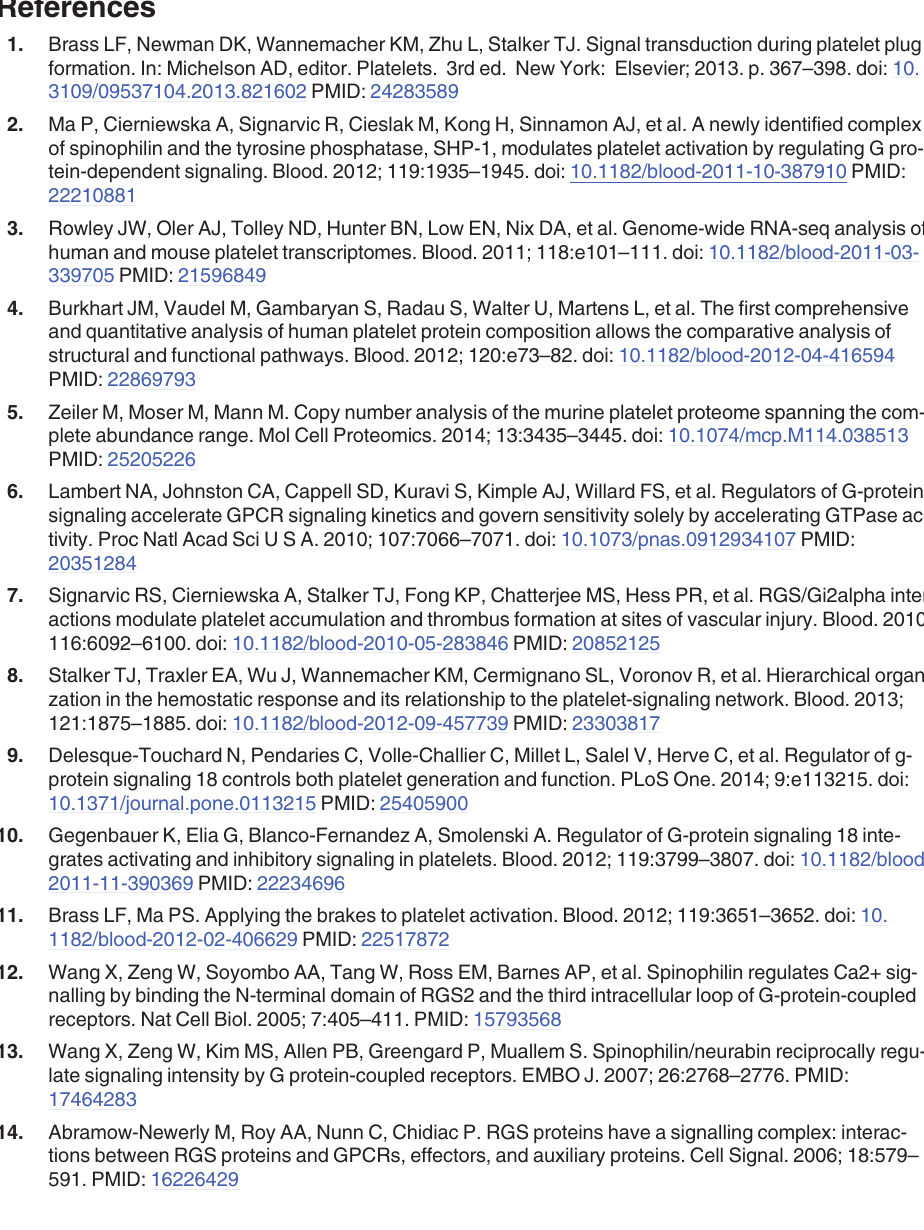
S2 Fig. Phosphatase assay. (A) CHO cells were transfected with either WT Flag-PP1 α or Flag- PP1 α (D95A), or were mock transfected. Afterwards the lysates were immunoprecipitated and phosphatase activity measured in the precipitate using a fluorogenic substrate (mean ± SEM, N = 3). (B) Immunoblot showing comparable expression of wild type and D95A spinophilin in transfected CHO cells.